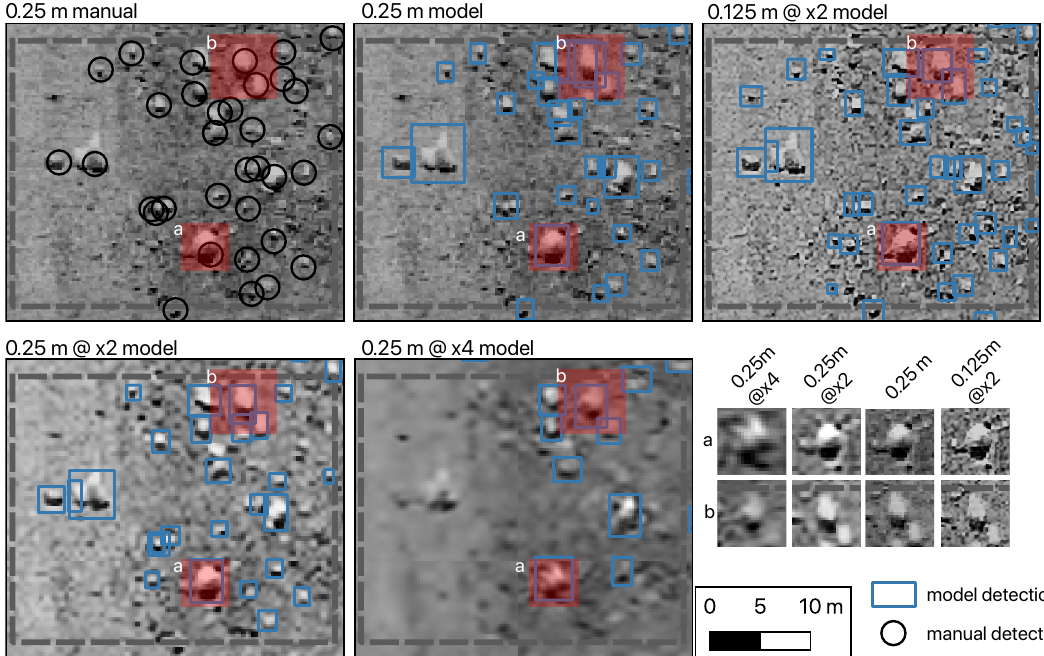
Figure 8. Subsets of the native and upscaled mosaics for the large boulder facies. Manual and model detections are marked. Insets detail the appearance of individual boulders in the different mosaics. The location of the shown mosaic subset in the validation mosaic is marked in Figure 1.